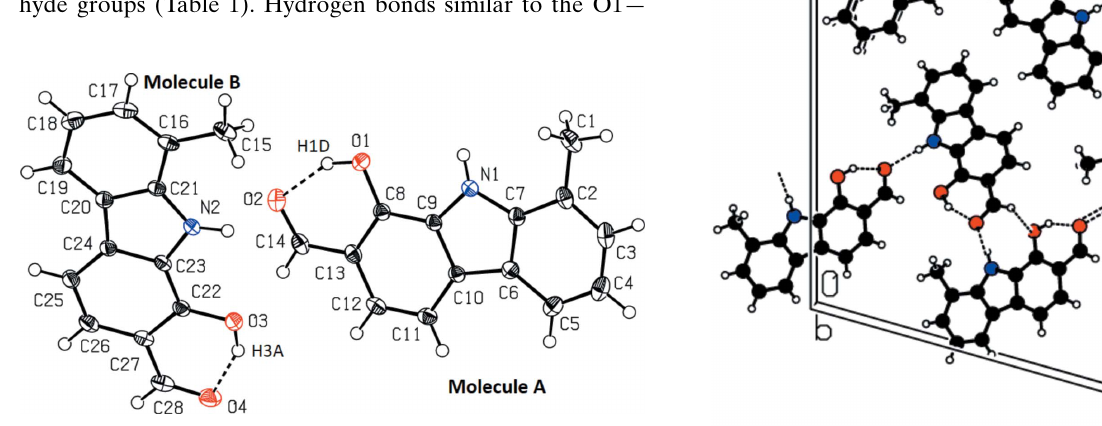
Figure 1 The two crystallographically independent molecules with the atom- numbering scheme. Non-H atoms are shown at the 50% displacement ellipsoid probability level, H atoms are represented as small spheres.